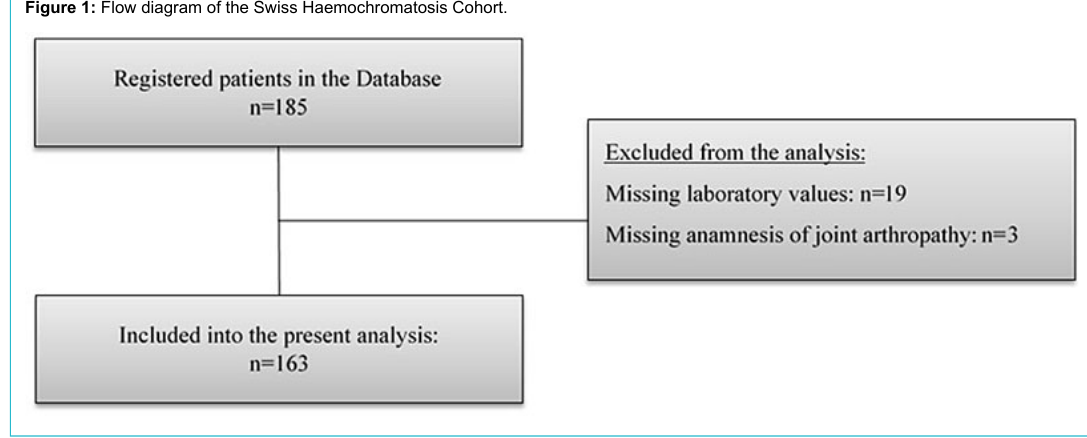
Table 1: Baseline characteristics, symptoms and laboratory measurements for patients with hereditary haemochromatosis included in the present analysis. Age (years), median (IQR) 48.0